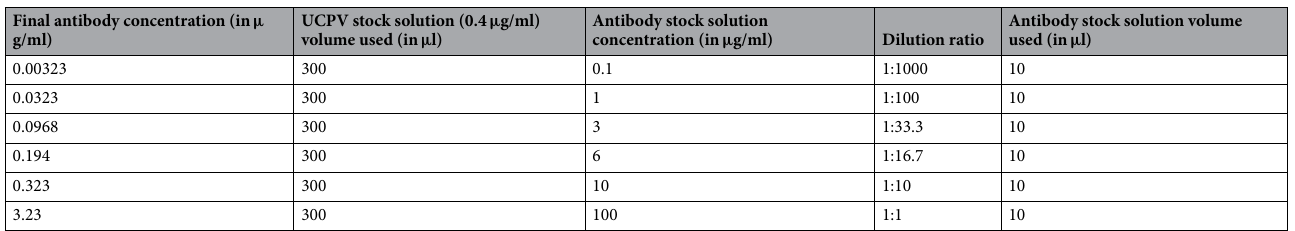
Table 1. Antibody concentrations and volumes used to prepare each final